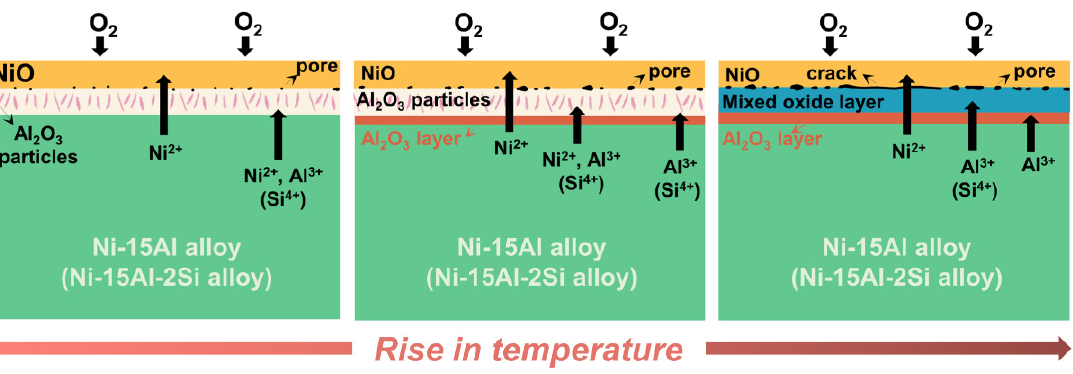
Figure 10. Mechanism diagram showing the influence of temperature on the evolution of oxide scales on Ni-15Al and Ni-15Al-2Si alloys oxidized in a temperature range of 700 ◦ C to 1200 ◦ C. Both Ni-15Al and Ni-15Al-2Si alloys form an internal oxidation zone after oxidation at relatively low temperatures for 576 h. There are many acicular or rod-like Al 2 O 3 particles dispersed in this zone (the left image of Figure 10). With the rising temperature, more Al 2 O 3 is generated and merges into an Al 2 O 3 layer at the front of the internal oxidation zone (the middle image of Figure 10). In the presence of the Al 2 O 3 layer, the internal diffusion of oxygen ions is effectively inhibited. When the temperature rises above 1100 ◦ C, the internal oxidation zone no longer exists and a mixed oxide layer, possibly composed of NiAl 2 O 4 spinel, is formed between the external and internal layers (the right image of Figure 10).